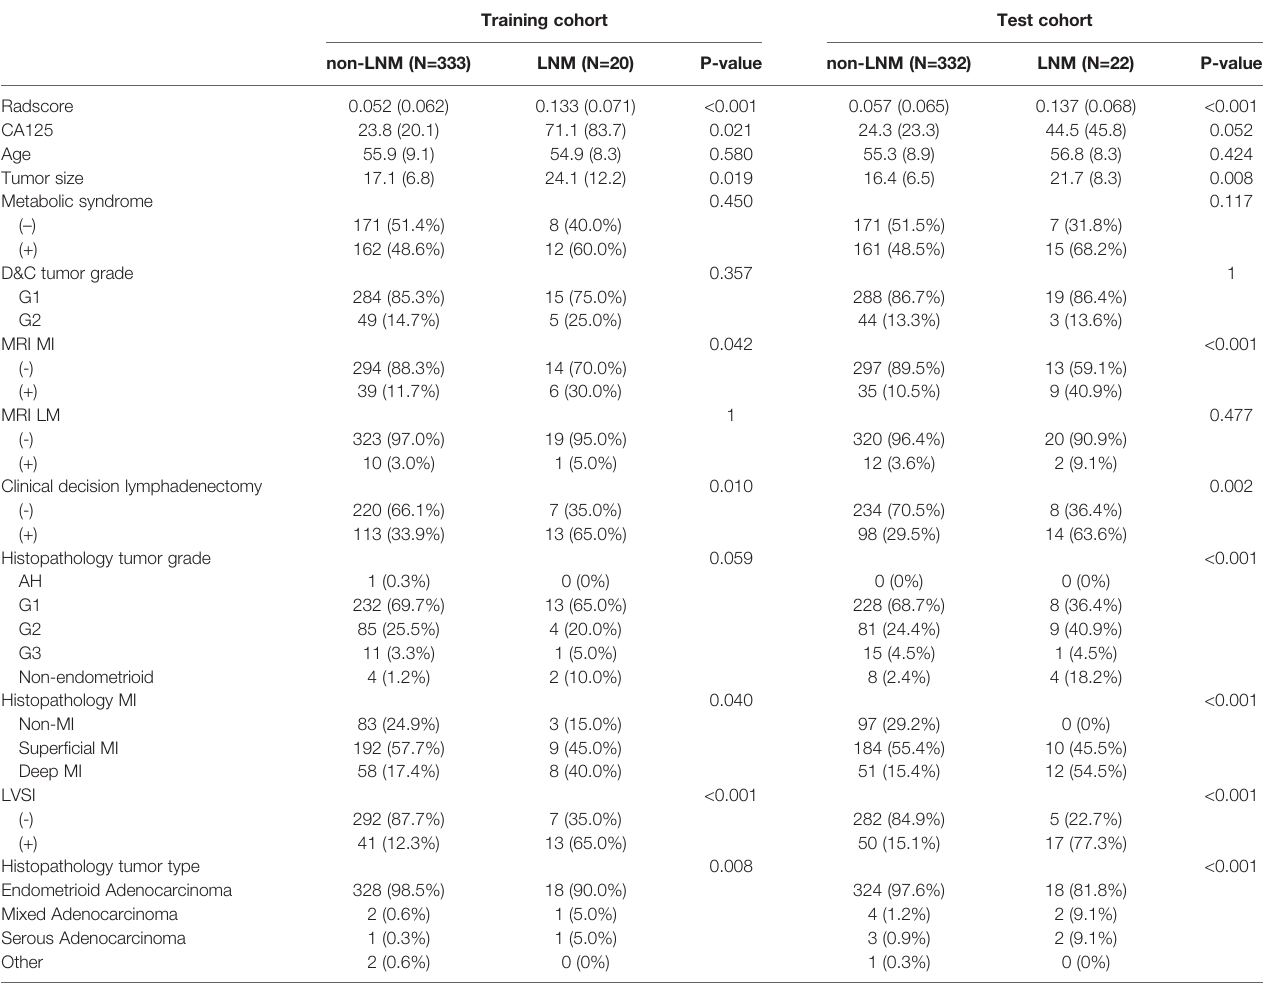
TABLE 1 | The comparisons of clinicopathologic characteristics between LNM and non-LNM patients in training and test